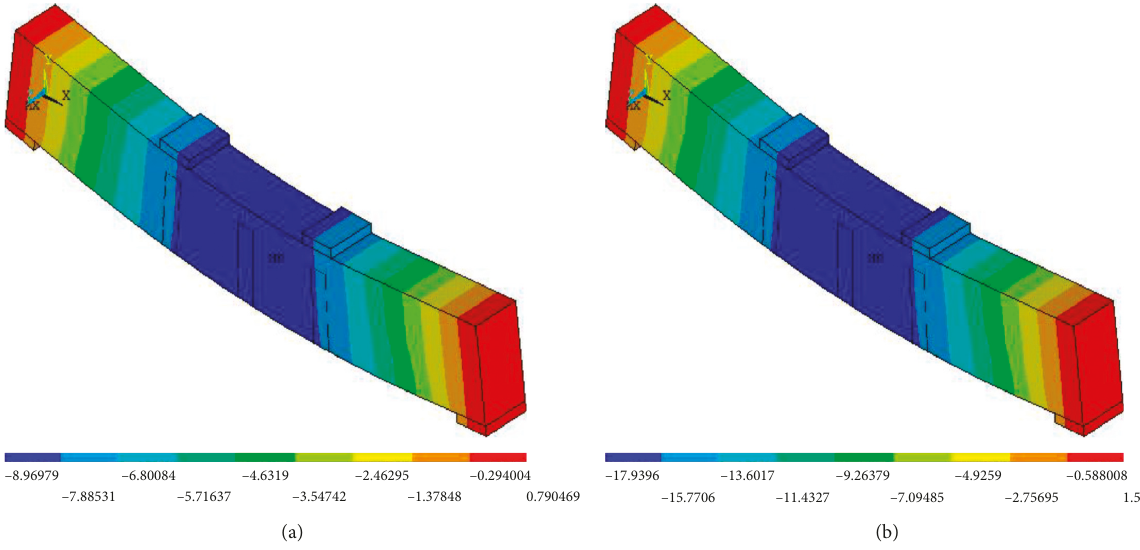
Figure 14: 3D views of deflections in the B6 model at (a) the yield load stage and (b) the maximum load stage.